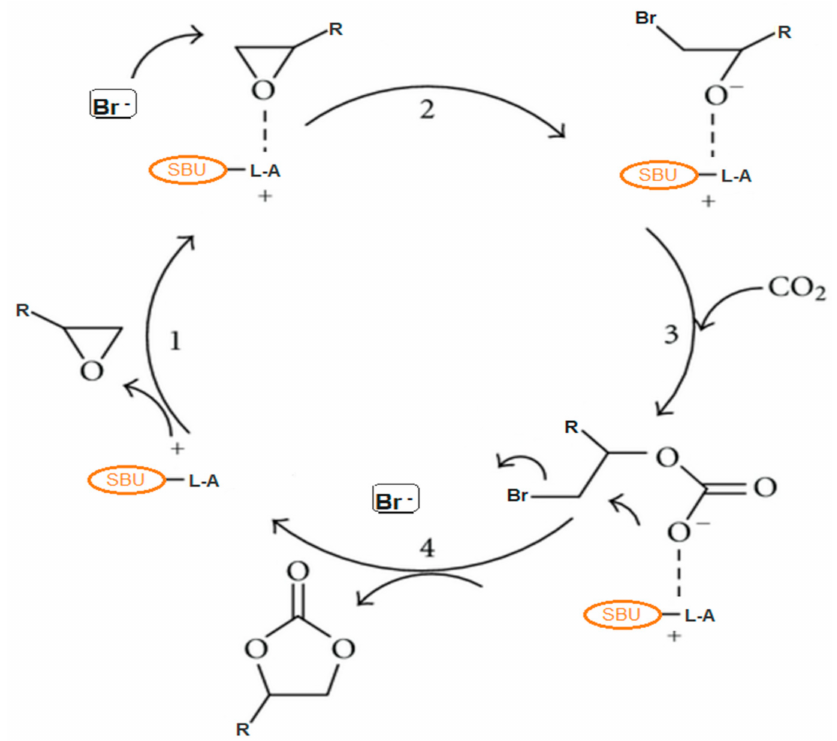
Figure 4. The general schematic reaction mechanism for CO 2 cycloaddition with epoxides catalyzed by a Lewis-acid catalyst MOF and TBABr co-catalyst